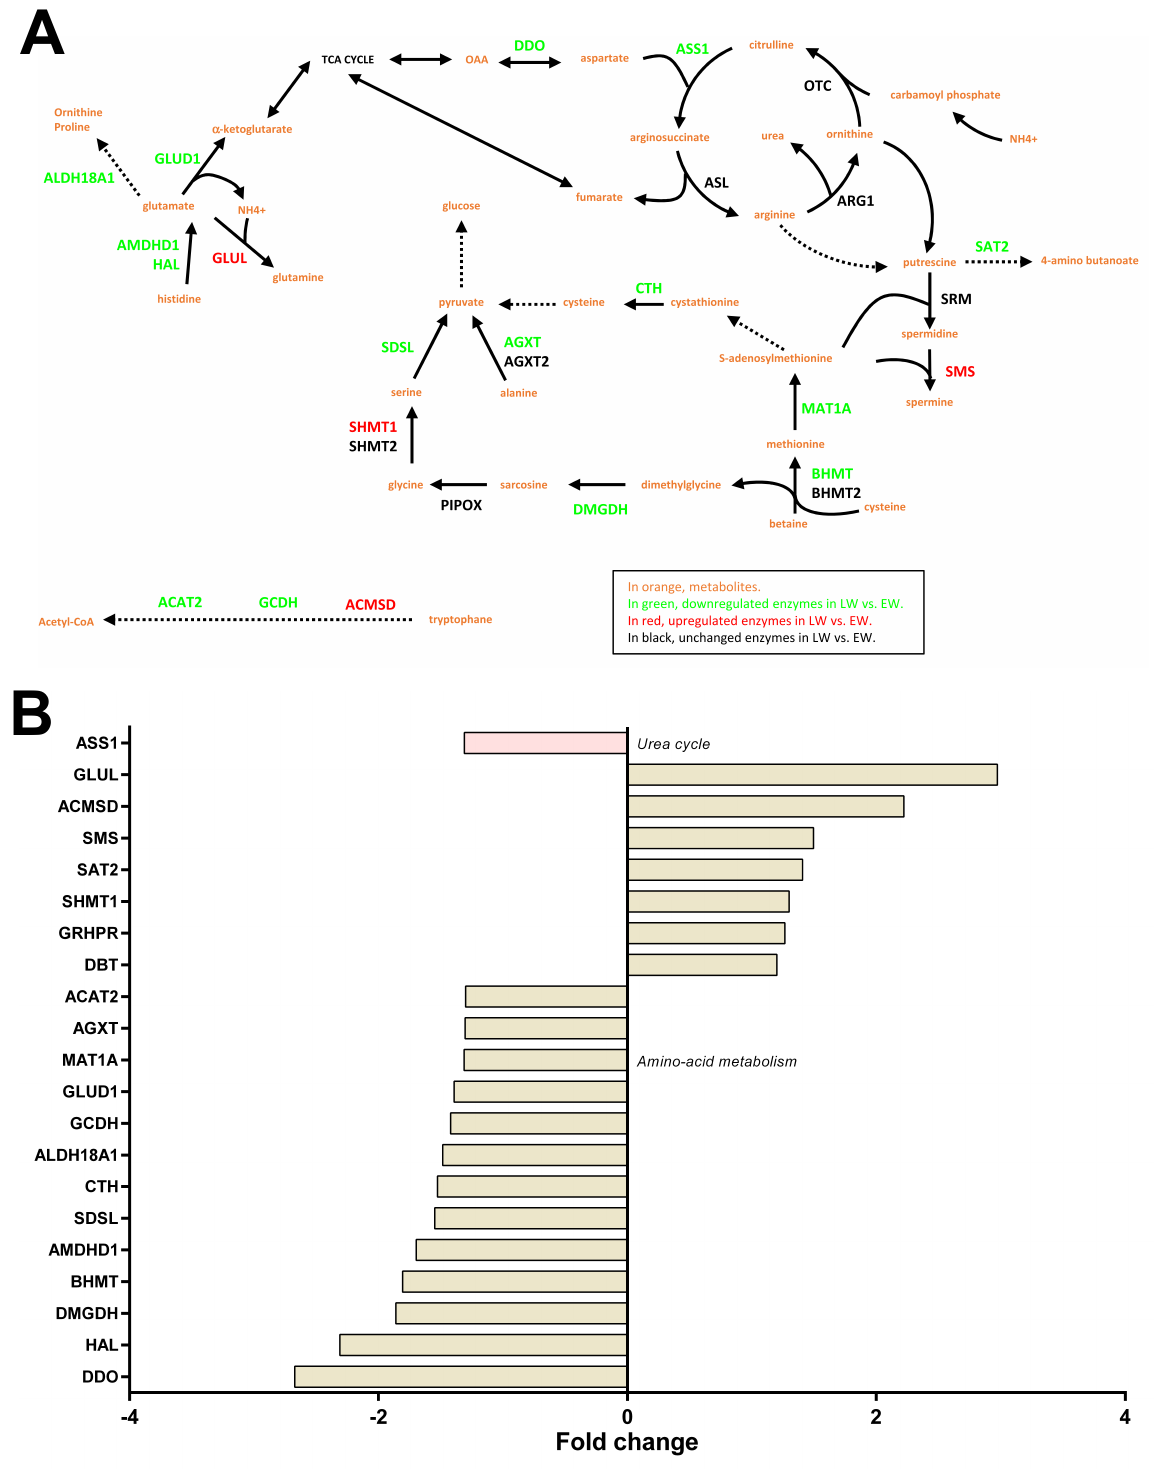
Figure 6. Regulation of liver amino acid metabolism and the urea cycle in grey mouse lemurs during winter. The relative abundance of liver proteins involved in amino acid metabolism and the urea cycle in early (EW) and late (LW) winter mouse lemurs (N = 5/group) is shown using a color code in the corresponding pathways (panel A ), and mean fold changes in LW vs. EW can be visualized in (panel B